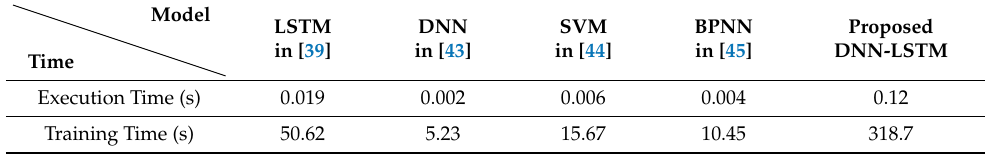
Table 13. Execution times and training runtimes of different forecasting